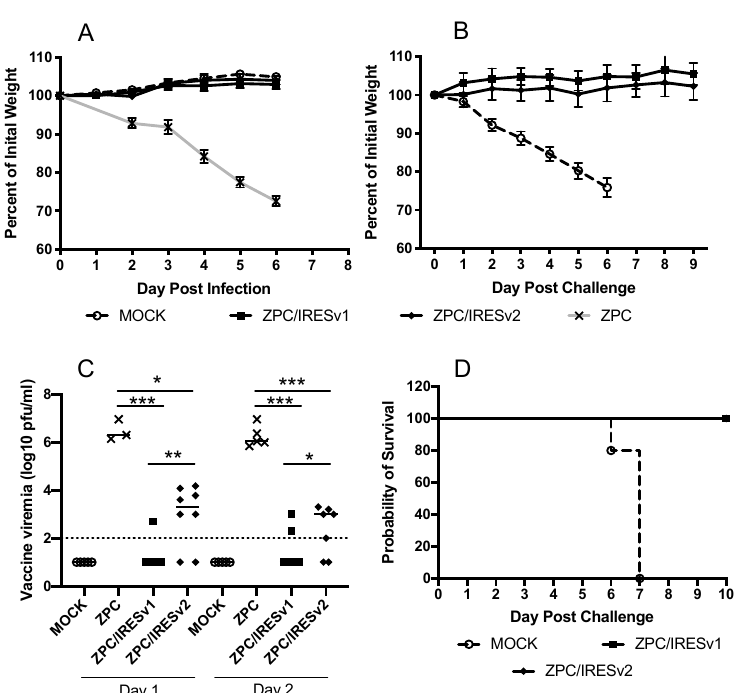
Figure 3. Vaccine efficacy in adult CD1 mice ( A , B ) Percent weight change following injection or vaccination or lethal challenge with VEEV 3908 from a representative experiment. The key for panels ( A , B ) are the same. ( C ) Viremia following virus infection or vaccination. Serum from blood collected on days 1 or 2 was analyzed and data from 2 independent experiments are combined. Significance directly comparing two groups was determined by unpaired t -tests; * p > 0.5, ** p > 0.01, *** p > 0.001. The solid line grouping with the data points represents the mean. The dashed line represents the assay limit of detection. ( D ) Survival in vaccinated groups following lethal challenge with VEEV 3908 from a representative experiment.